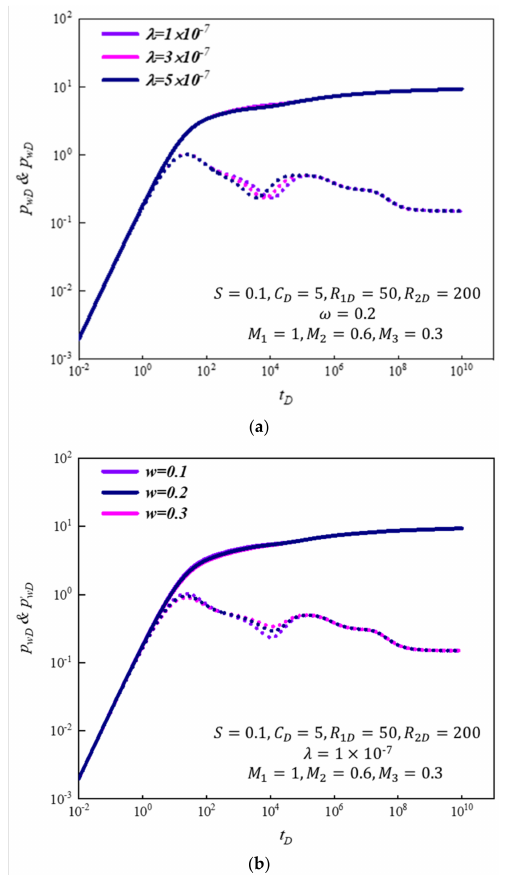
Figure 3. ( a ) The comparison of type curves under different λ ; ( b ) the comparison of type curves under different ω